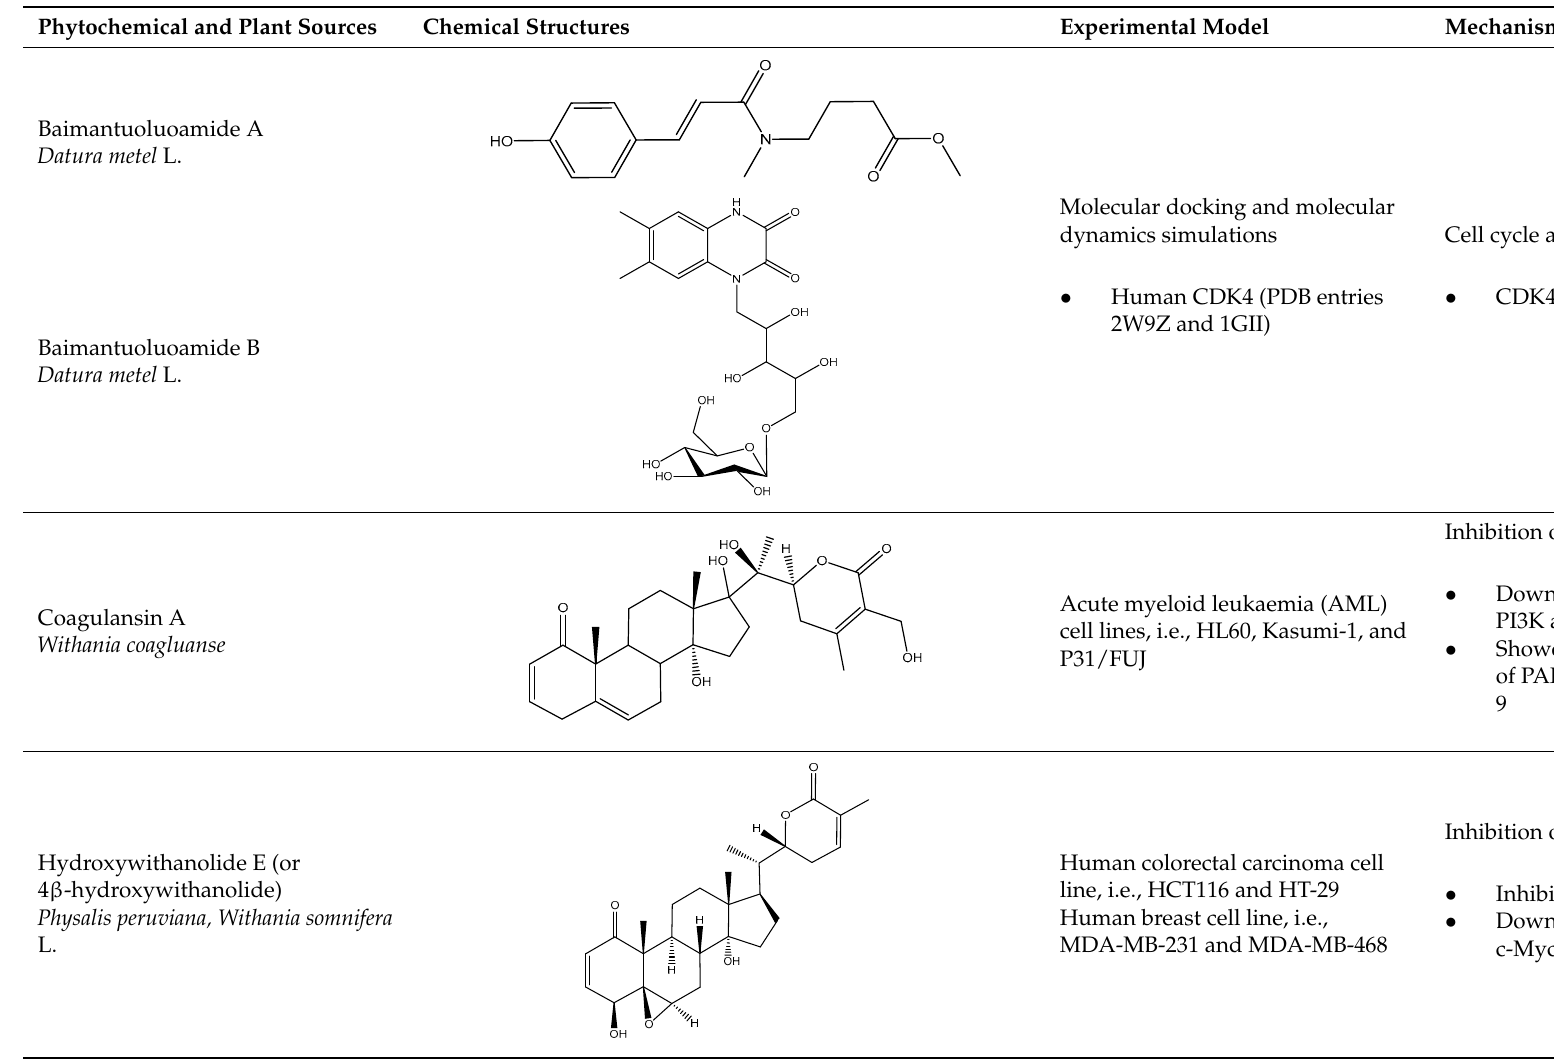
Table 1. Summary of plant metabolites and their mechanisms of action.